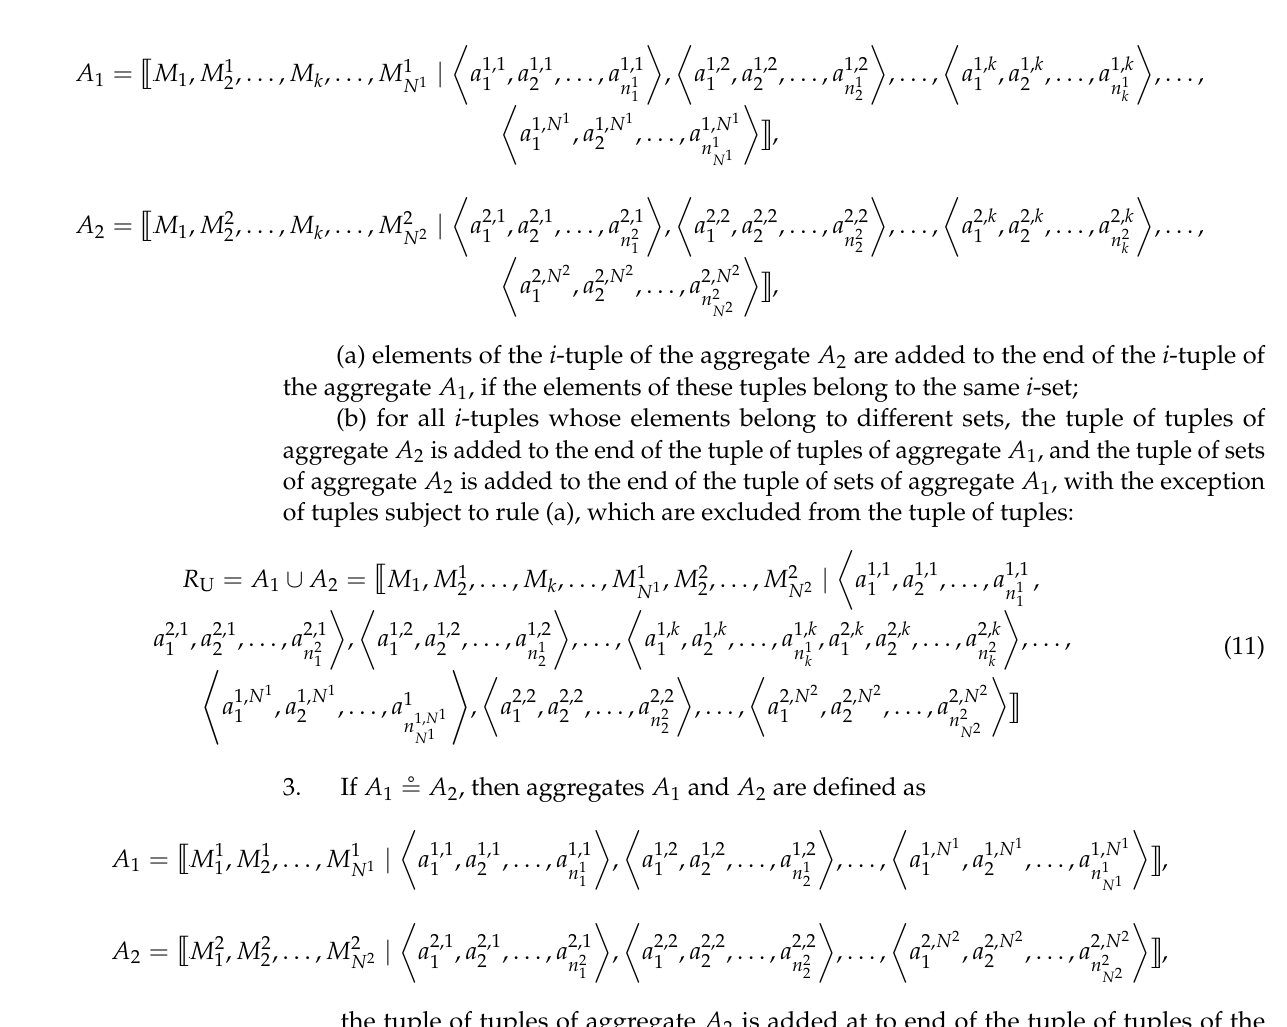
Figure 3. An example of two incompatible aggregates.